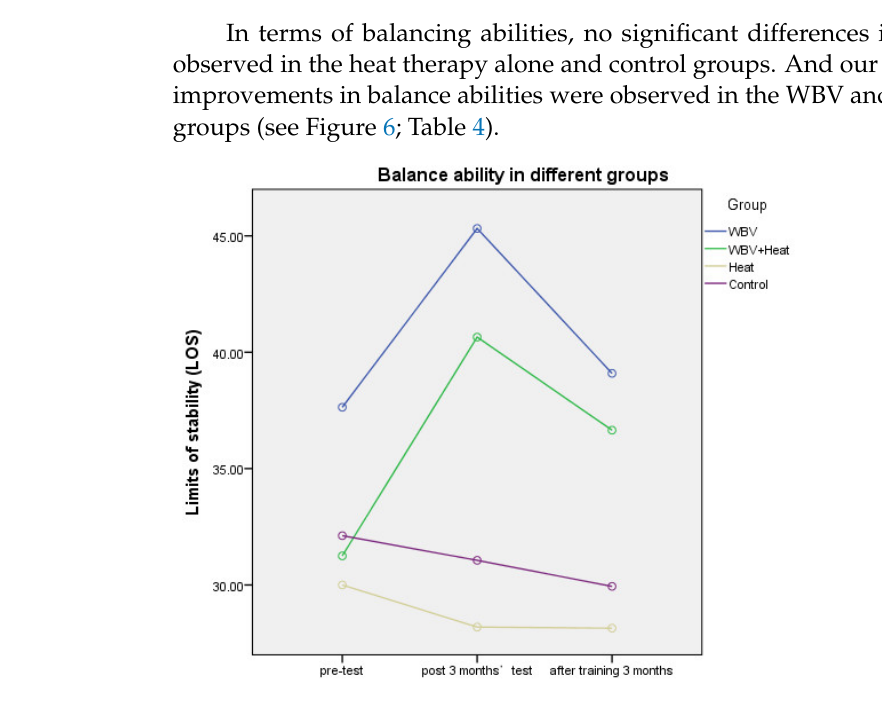
Figure 6. Balance in Six months with different groups. Table 4. Comparison of the Training Effect on Balance Performance in Six